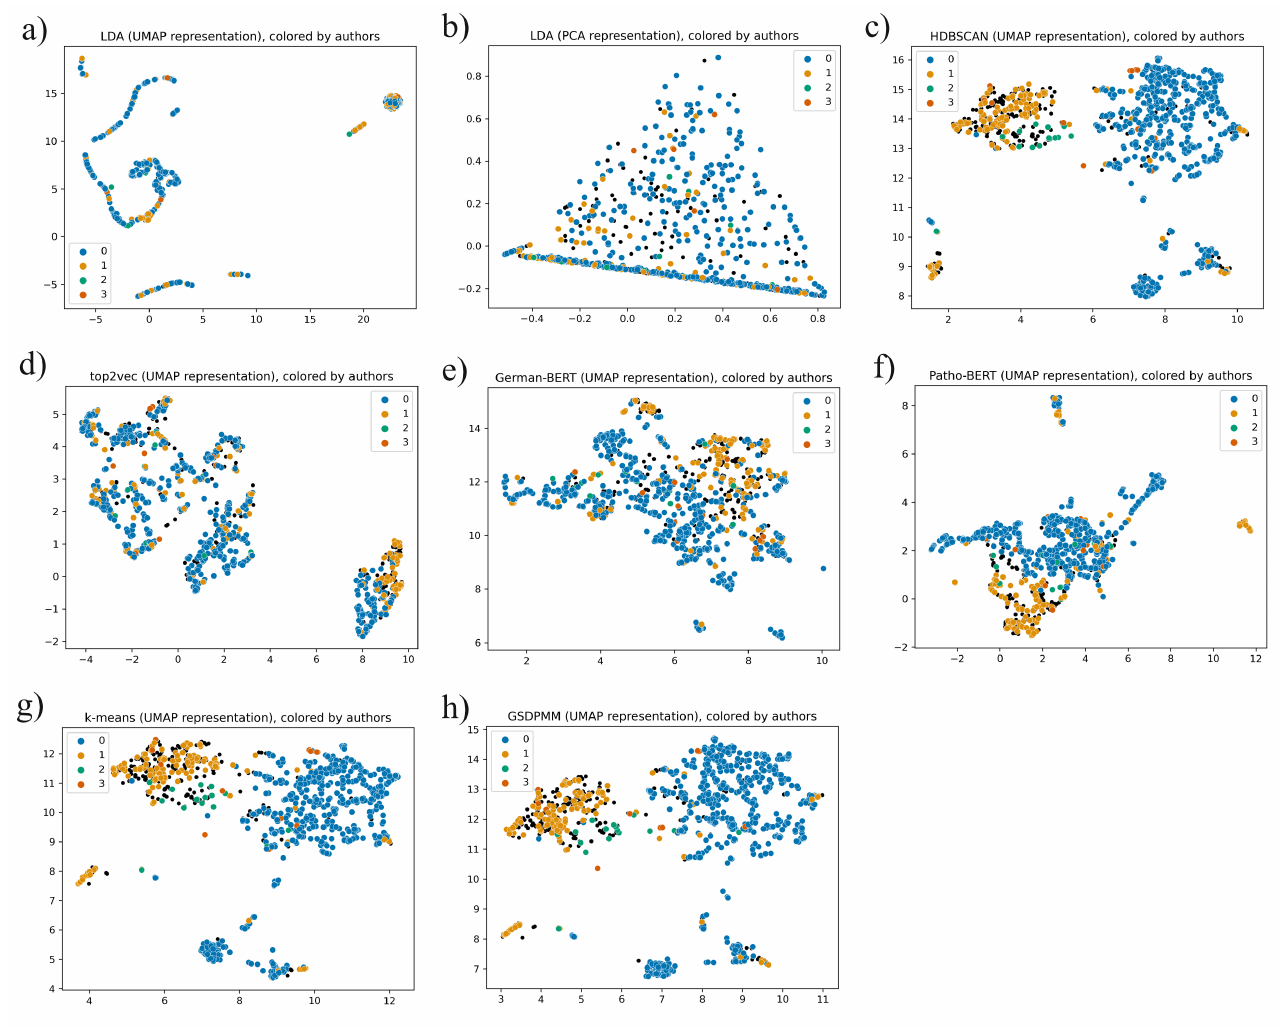
Figure A1. UMAP! ( UMAP! ) of the cluster-sets generated with ( a ) LDA! ( LDA! ), ( c ) HDBSCAN! ( HDBSCAN! ), ( d ) top2vec, ( e ) German-BERT, ( f ) Patho-BERT, ( g ) k-means and ( h ) GSDPMM! ( GSDPMM! ). The LDA! ( LDA! ) cluster-set is also shown as PCA! ( PCA! ) in ( b ). Each dot colour represents a different author. The authors of the reports marked in black are unknown (e.g. because multiple authors were